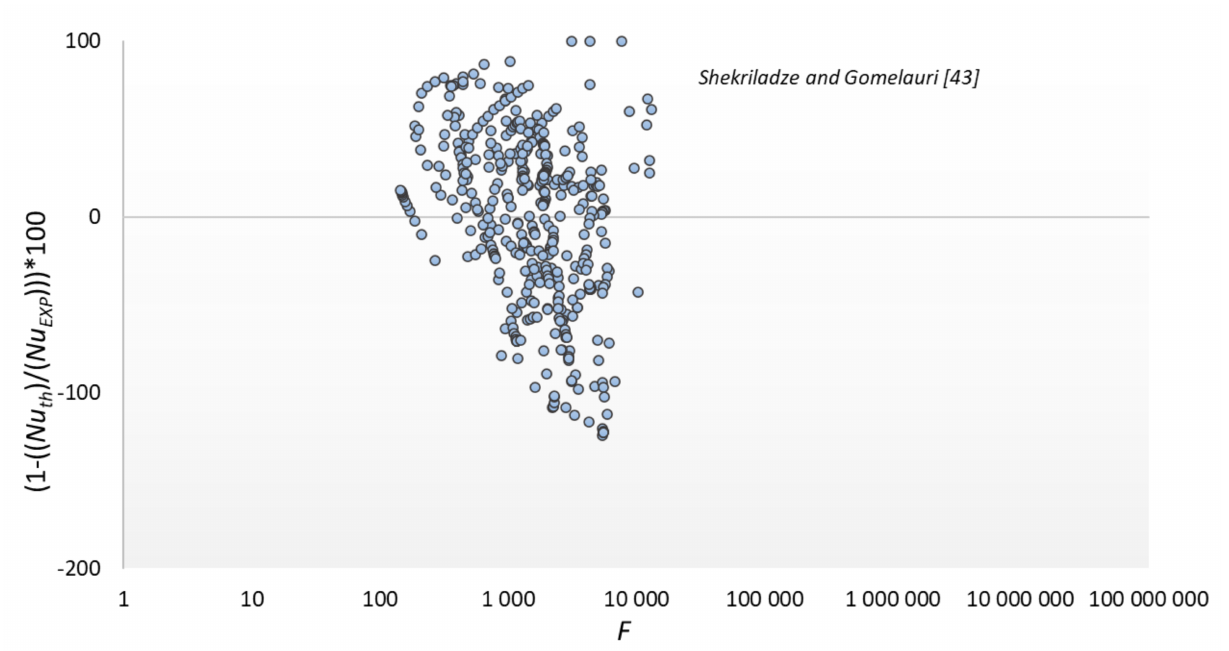
Figure 16. Comparison of experimental data to the model of Shekriladze and Gomelauri